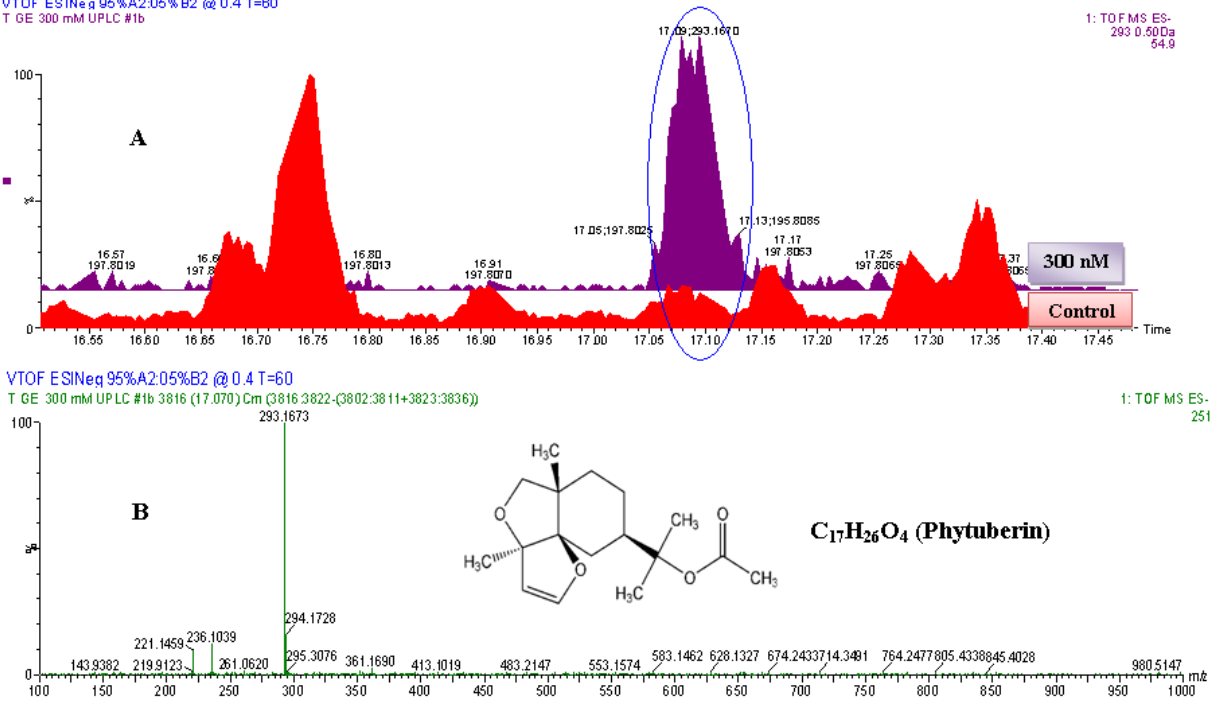
Figure 5. The identification of phytuberin. ( A ) The zoomed-in extracted ESI − -MS TICs comparing non-treated (control) and 300 nM-treated samples. The encircled ion peak is present only in the treated sample: the intensity of the peak is significantly higher in the 300 nM-treated sample than in non-treated (control) sample. ( B ) MS-spectrum of the extracted ion peak, eluted at 17.1 min (293.1673 Da). Based on the spectrum of the extracted ion peak, the empirical formula calculated (and selected) was C i-FIT of 0.0 and DBE of 5.5. Since the ion was generated by ESI − mode, the calculated empirical formula would contain one proton (H + ) less. The corrected empirical formula is thus C H O ; and searching in databases (with structural correlation to MS spectrum) 17 26 4